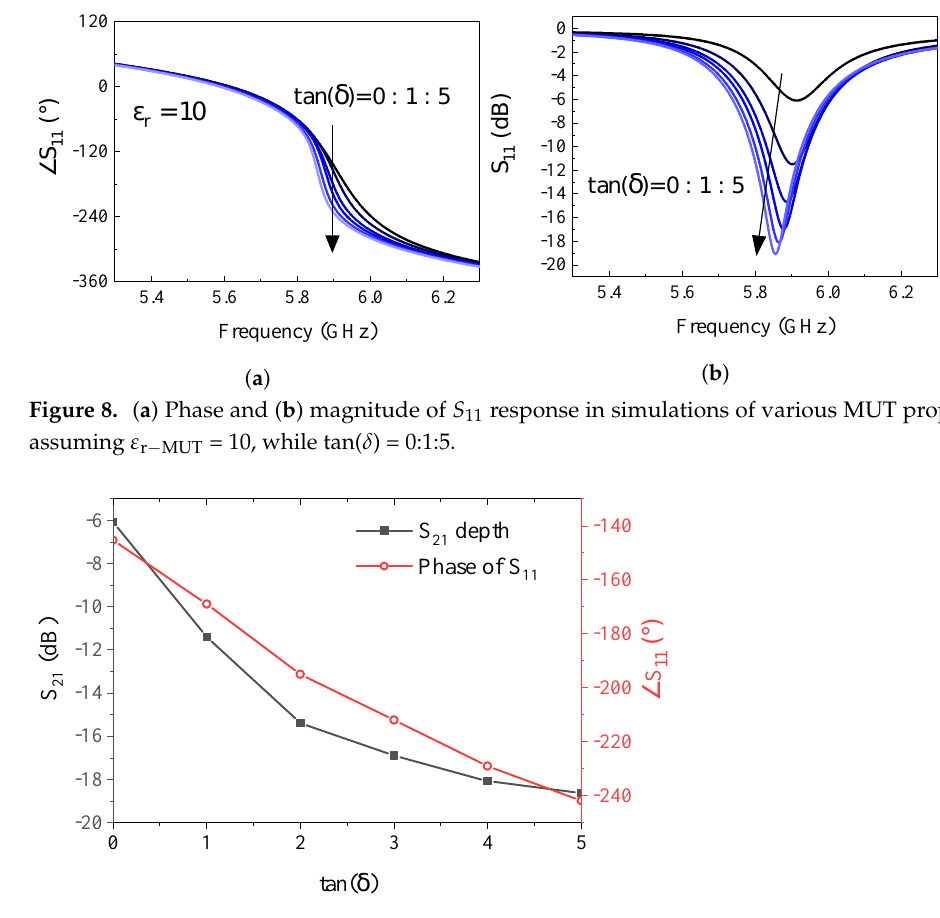
Figure 9. Comparison between S 11 depth and phase